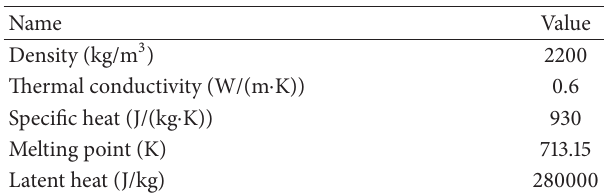
Table 1: Thermophysical properties of the NaCl-MgCl 2 salt in the validation